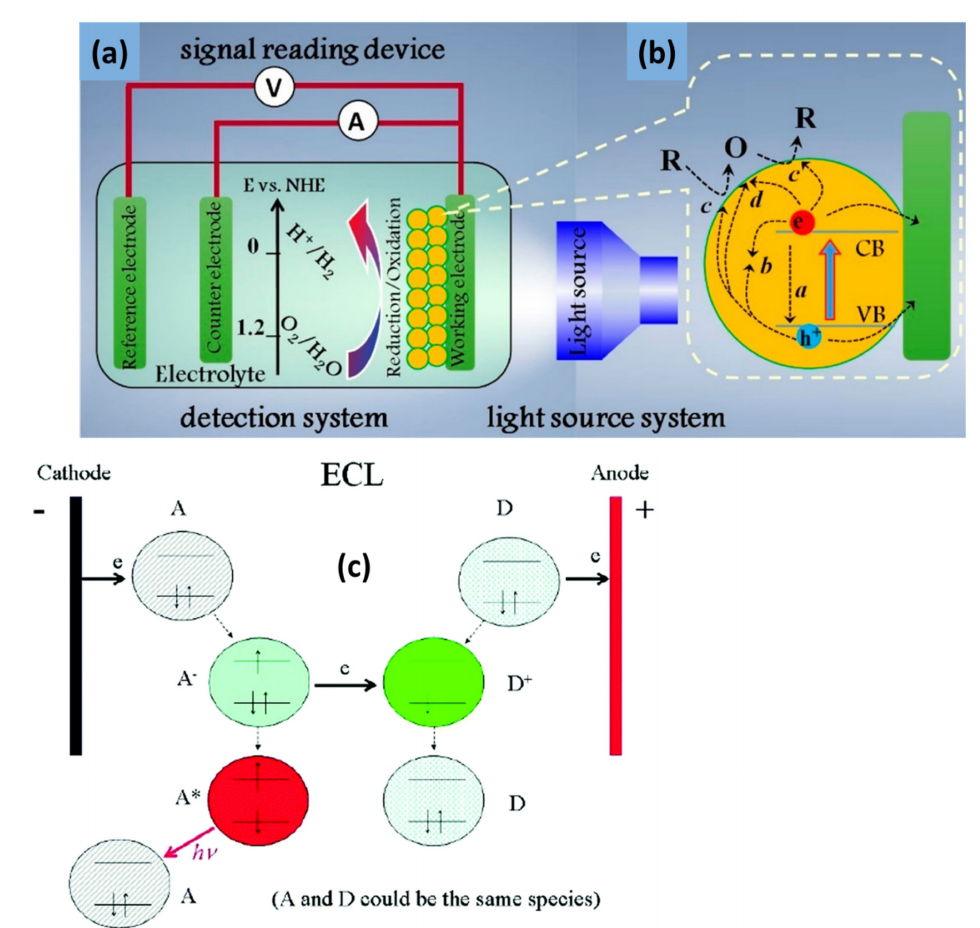
Figure 7. ( a ) Schematic representation of PEC sensing with a traditional three-electrode system, ( b ) the photocurrent generation mechanism, [173], and ( c ) schematic representation showing the general principles of ECL [184]. Figure reproduced with permission from Ref. [173] copyright © 2020 American Chemical Society, Ref. [184] copyright © 2007 Elsevier